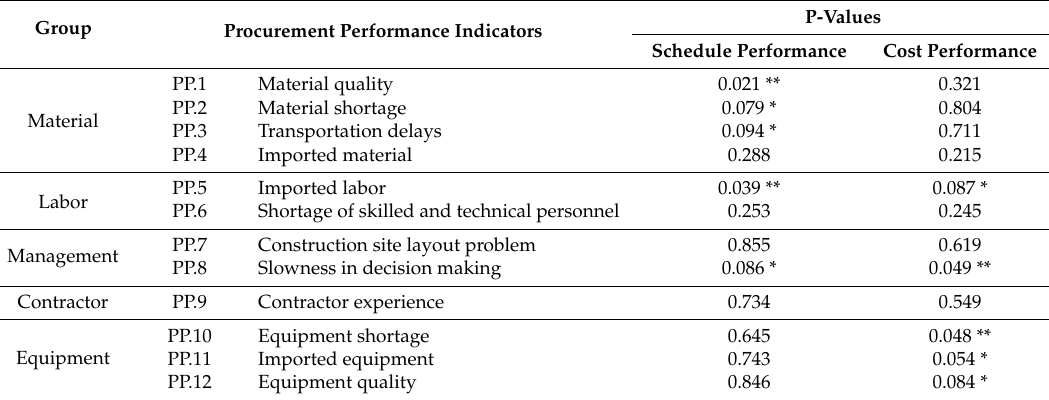
Table 4. Procurement Phase Cost and Schedule Performance